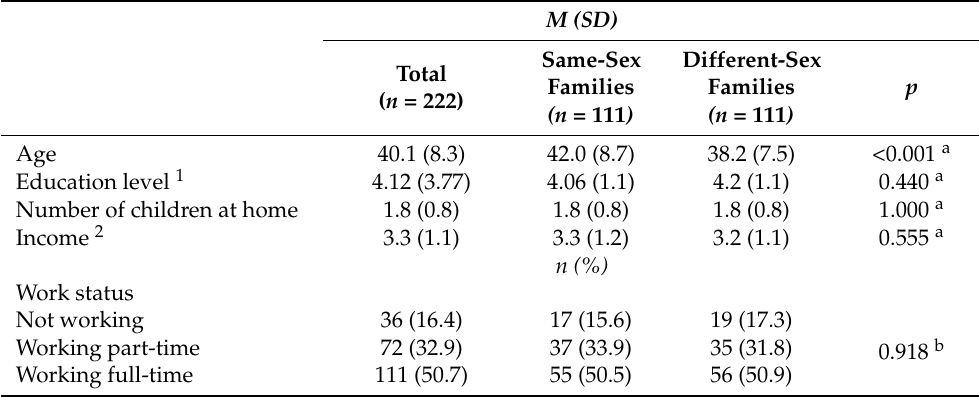
Table 2. Sociodemographic Variables as a Function of Family Type (Study